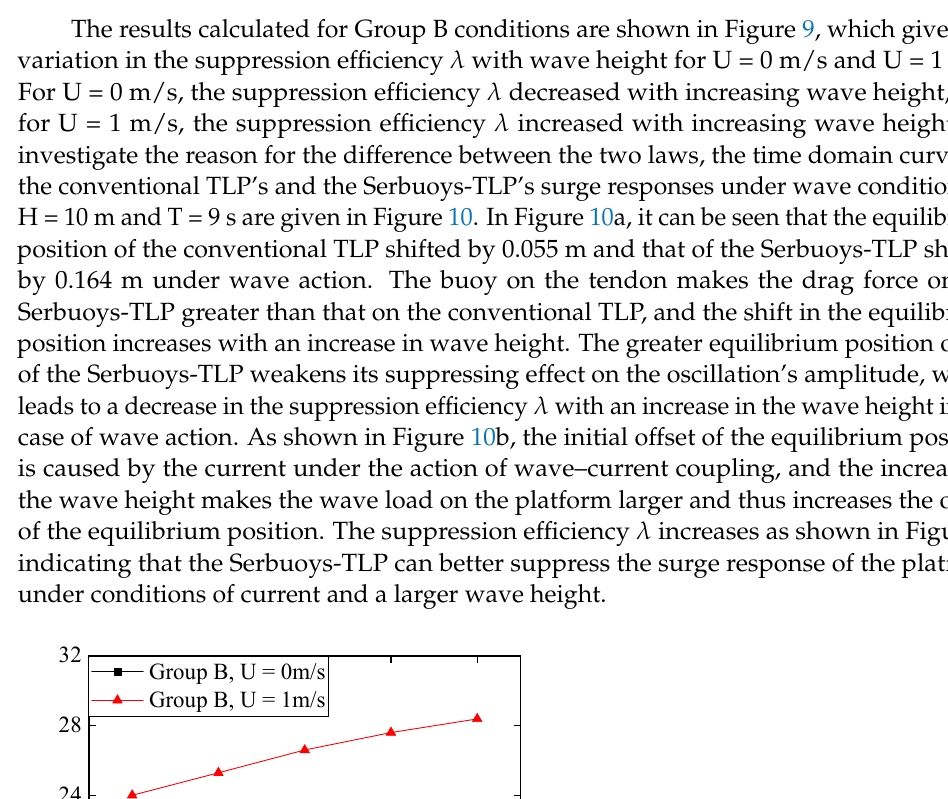
Figure 8. Surge suppression efficiency of the Serbuoys-TLP under different current velocities.